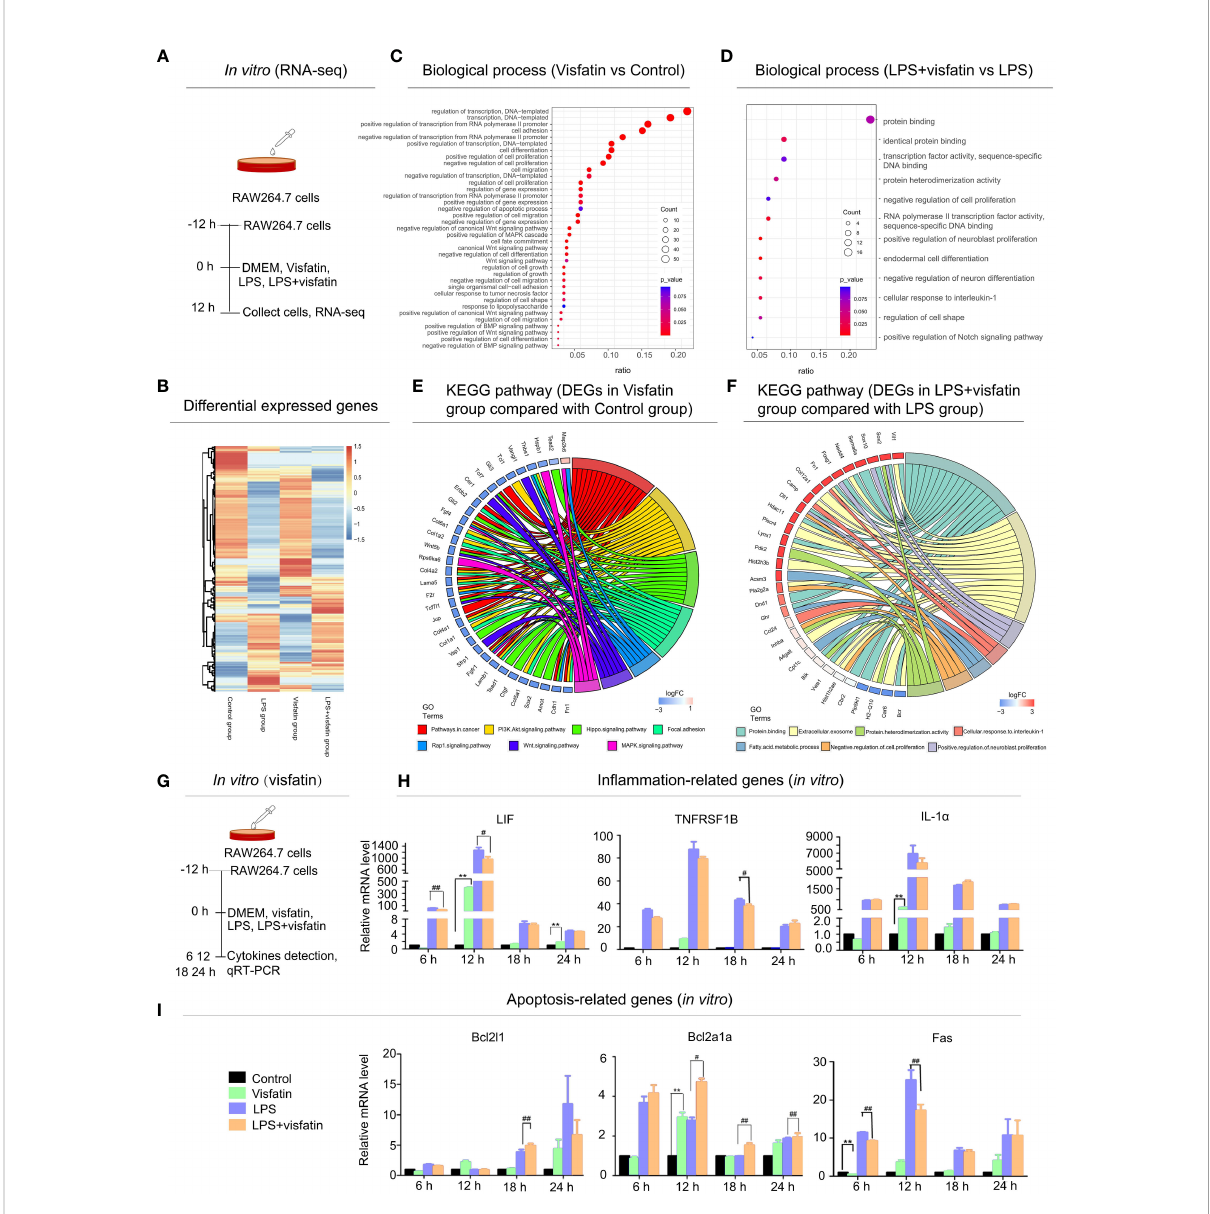
FIGURE 2 Effects of exogenous visfatin on in fl ammation and apoptosis in RAW264.7 cells detected by RNA-seq analysis. (A) Treatment of RAW264.7 cells in different ways for RNA-seq analysis after 12 h ( in vitro ). (B) Heatmap of regulated DEGs between Control, Visfatin, LPS and LPS+visfatin in four groups illustrating the gene expression patterns. (C, D) Gene ontology analysis of regulated DEGs were displayed for Visfatin vs Control and LPS+visfatin vs LPS groups, enriched terms were ranked by gene ratio and -log10 ( P value). (E, F) GO plots were used for seven most signi fi cant pathways and biological processes for Visfatin vs Control, LPS+visfatin vs LPS group. Associated DEGs were also checked to reveal the reaction after treatment with LPS. (G) In vitro veri fi cation of RNA-seq analysis results. (H, I) Detection of in fl ammatory factors and apoptosis-related cytokines in RAW264.7 cells of different treatment groups (compared with the control group: ** P <0.01; compared with the LPS group: # P <0.05, ## P